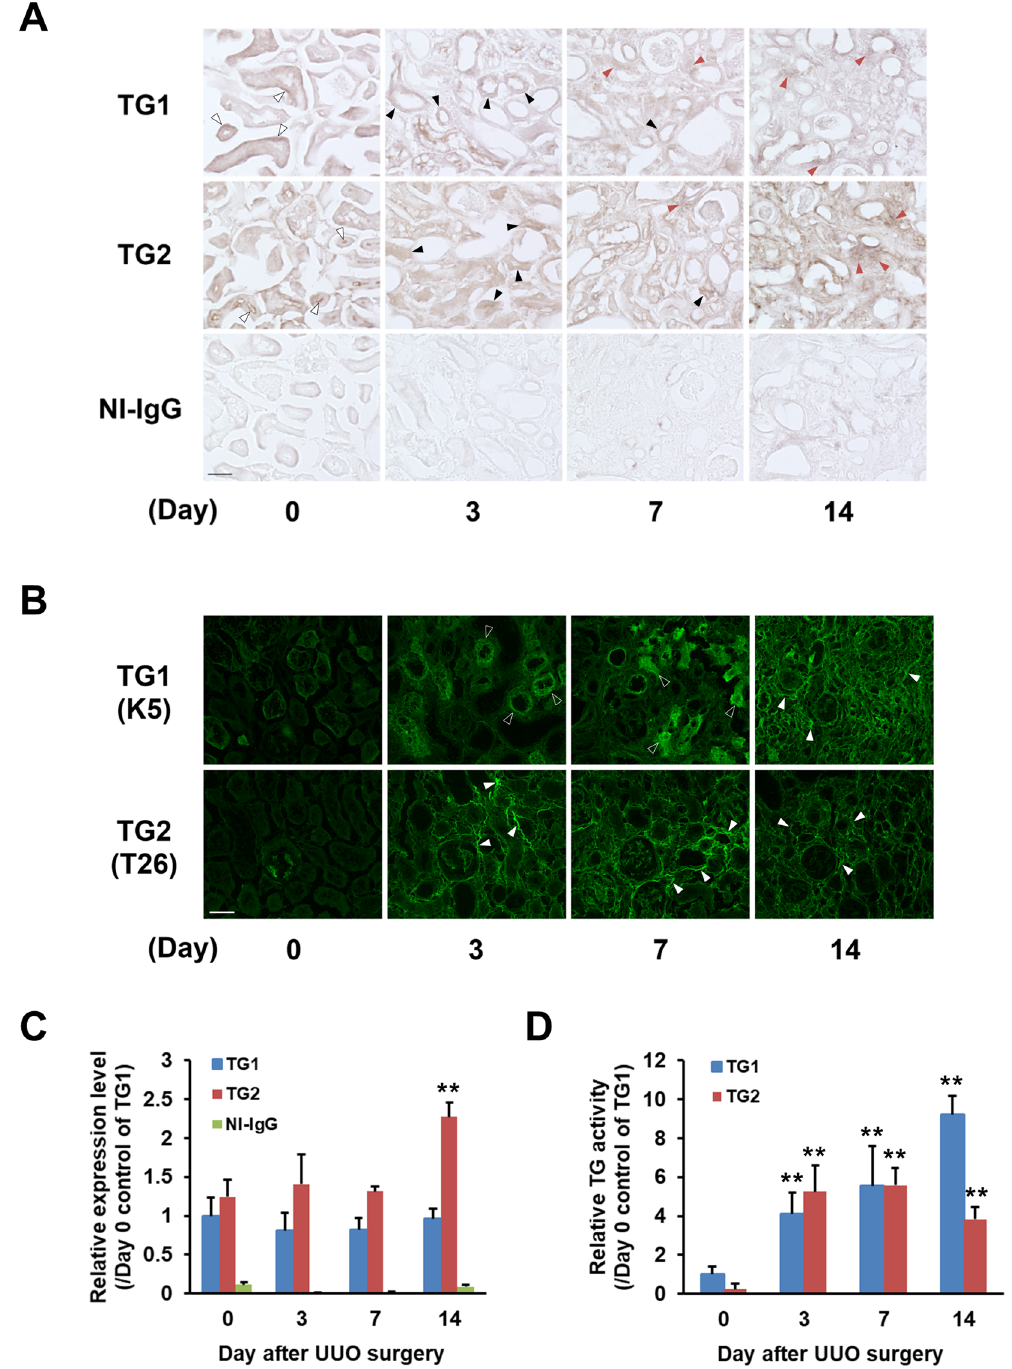
Figure 3. Distributions of the expressions and activities of TG1 and TG2 in fibrotic kidneys. Each kidney section was subjected to the immunohistochemistry and in situ TG activity staining on the indicated days after UUO surgery. ( A ) Immunostaining was performed using polyclonal anti-mouse TG1 and TG2 antibodies, and rabbit NI-IgG as the negative control. Three kinds of arrowheads indicate the areas where staining is changing for TG1 and TG2 such as tubule basement membrane and lumen (white arrowheads), tubular epithelial cells (black arrowheads), and interstitial areas (red arrowheads). Bar = 50 μ m. ( B ) The in situ activities of TG1 and TG2 were visualized using FITC-labeled substrate peptides (pepK5 and pepT26, respectively). The white frame and white arrowheads indicated the notable tubular epithelial cells and interstitial areas, respectively. Bar = 50 μ m. The relative intensities from ( A ) and ( B ) were presented in ( C ) and ( D ), respectively. The data are presented as the mean ± SD ( n = 4) ( ** P < 0.01, Student’s t